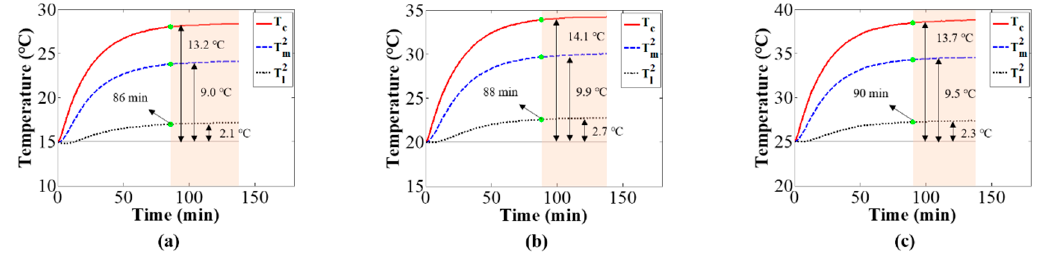
Figure 14. Camera component temperature variation over time under di ff erent constant environmental temperatures: ( a ) T e = 15 ◦ C, ( b ) T e = 20 ◦ C, and ( c ) T e = 25 ◦ C.